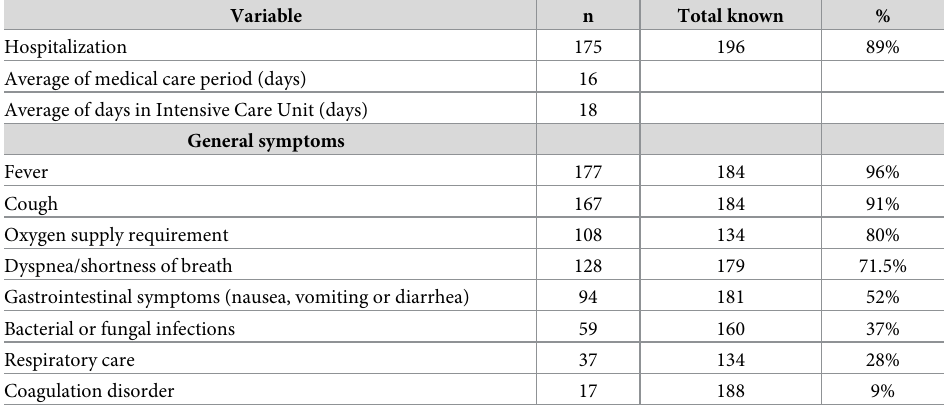
Table 1. Characteristics of the study patients. n Total known % Age, mean (range) 62 (25–92) 196 � 65 years old 86 (43/43) 196 44% Sex (male/female) 105/91 196 54%/46% BMI, mean 29,5 127 Ongoing/history of smoking 87 152 57% Ongoing/history of snuffing 21 52 40% Ongoing /history of alcohol overconsumption 13 56 23% Comorbidities Hypertension 97 178 54.5% Depression and anxiety 81 160 51% Sleep disorders (insomnia and/or OSAS) 50 165 30% Cardio- or cerebrovascular disease 46 166 28% Autoimmune disease 39 156 25% Chronic Lung disease (Asthma and/or COPD) 38 (37) 159 24% (23%) Diabetes Mellitus type II 38 164 23% Allergic Rhinitis/Pollen allergy 27 171 16% Chronic kidney disease 17 162 10.5% Thromboembolic disease 14 155 9% Other psychiatric disorders 5 156 3% Table 1 shows the overall demographics and comorbidities of study patients. “n” shows the number of patients who replied positive to the corresponding variable, “total known” represents the total number of patients who replied to the corresponding question and the column to the most right shows the percentage of occurrence of each variable in regard to the respective total known cases. OSAS = Obstructive Sleep Apnea.